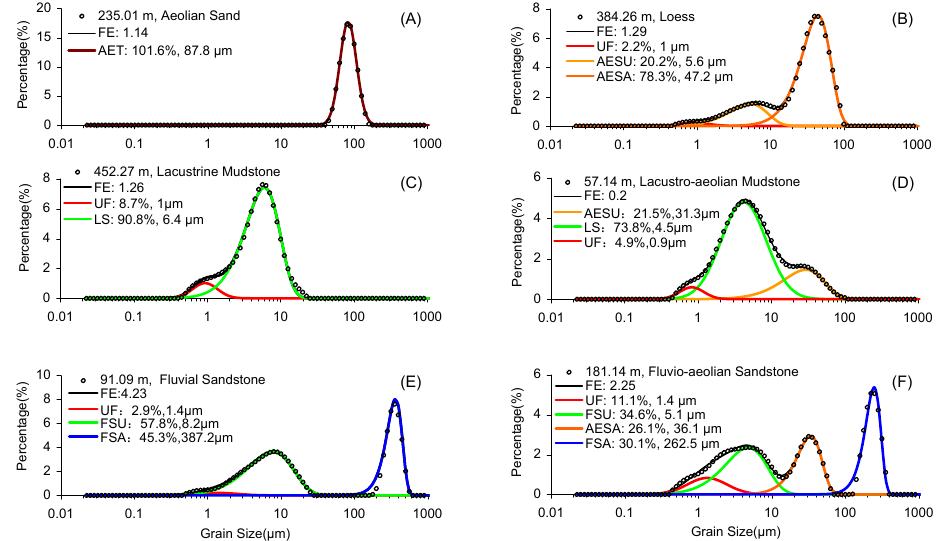
Fig. 3. Grain-size distribution of representative samples from the HBS section. The specific sedimentary components were partitioned and identified using the grain size distribution developed by Sun D. et al. (2002). Abbreviations: FE-fitting curve with error, UF-ultrafine compo- nent, AESU-aeolian suspension component, AESA-aeolian saltation component, AET-aeolian traction component, LS-lacustrain suspension component, FSU-fluvial suspension component, FSA-fluvial saltation